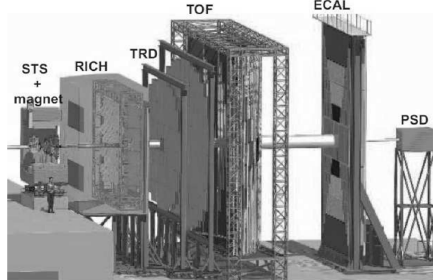
Figure 1. General view of the CBM setup